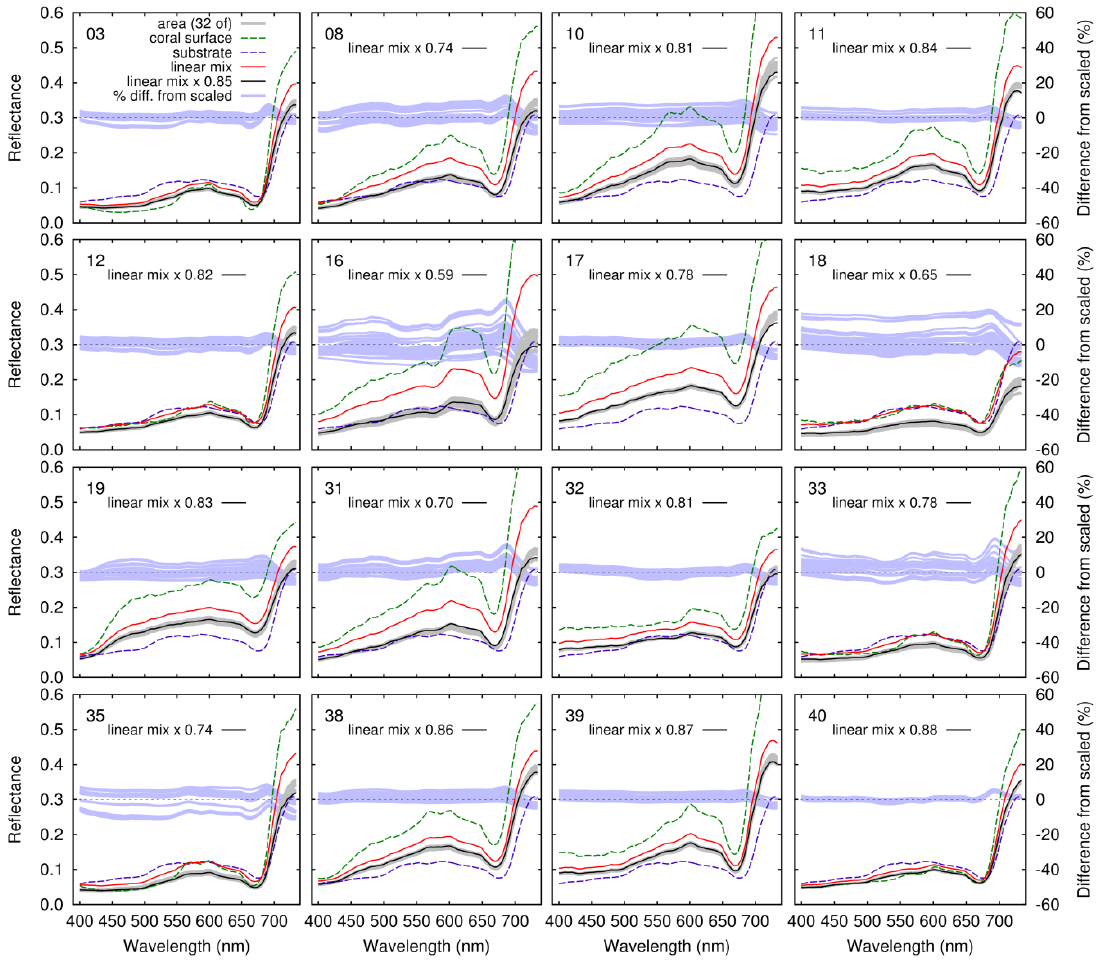
Figure 6. Reflectance over coral structure and surrounding substrate to give a 50% mix in areal cover. Plots show the coral surface and substrate surface reflectances (thin and thick green lines), and a 50% linear mix of those reflectances (red), reflectance over the coral and substrate area under 32 treatments (grey), surface reflectance scaled by shading factor (black), and % difference of each treatment from scaled surface reflectance (light blue, right hand y-axis).